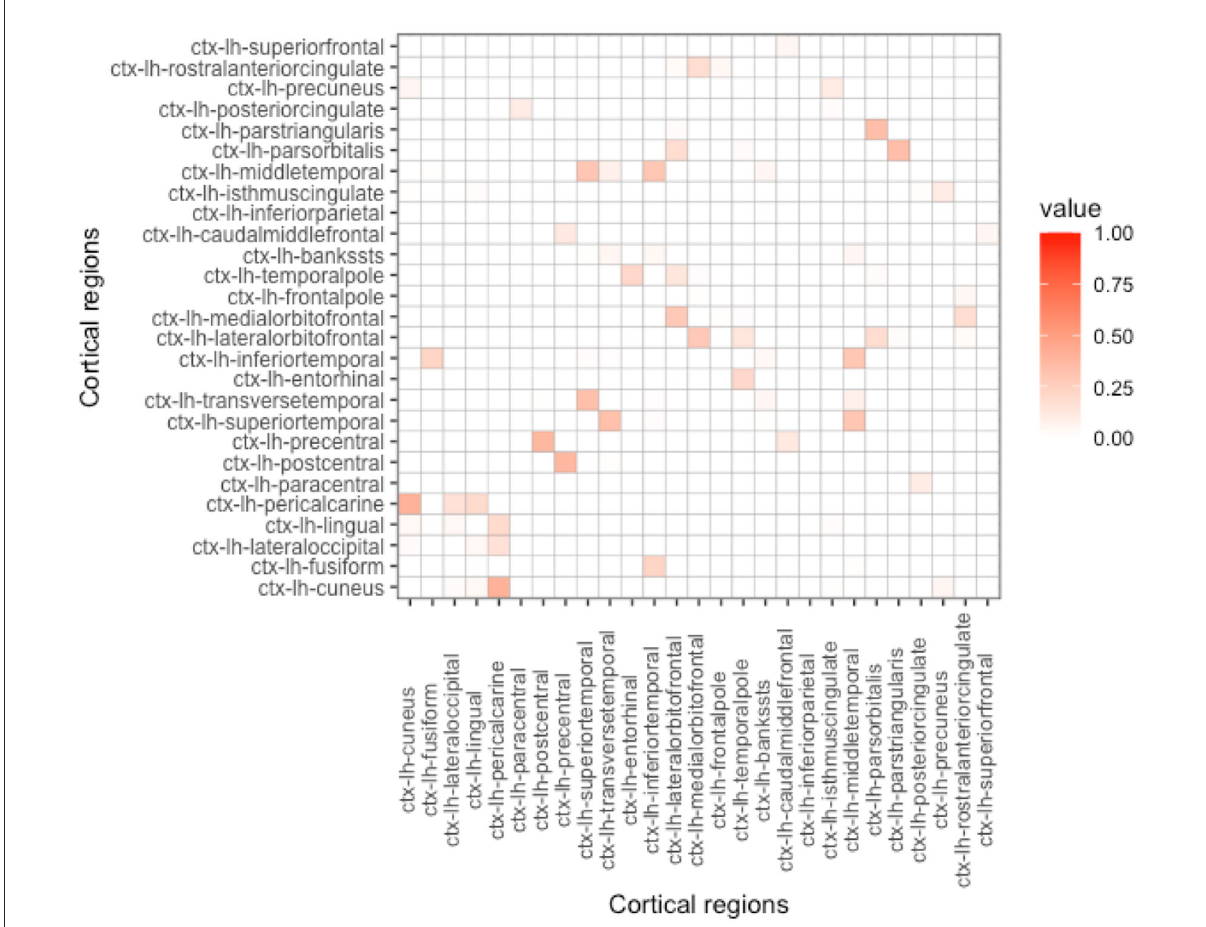
FIGURE4 Proximity matrix displayed for the left hemisphere, Euclidean distance, and parameter h in the Supplementary